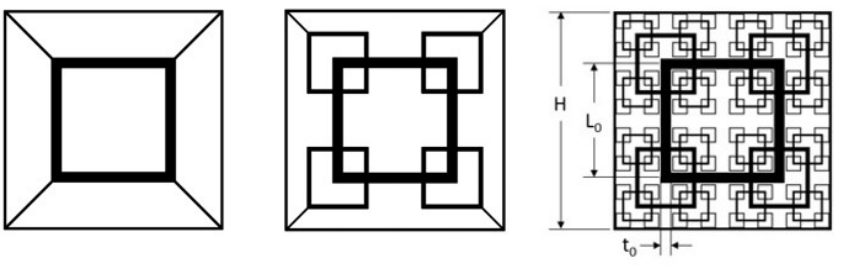
Figure 1. Definition of scaling parameters of a fractal square grid. FG1, FG2 and FG4 from left to right.